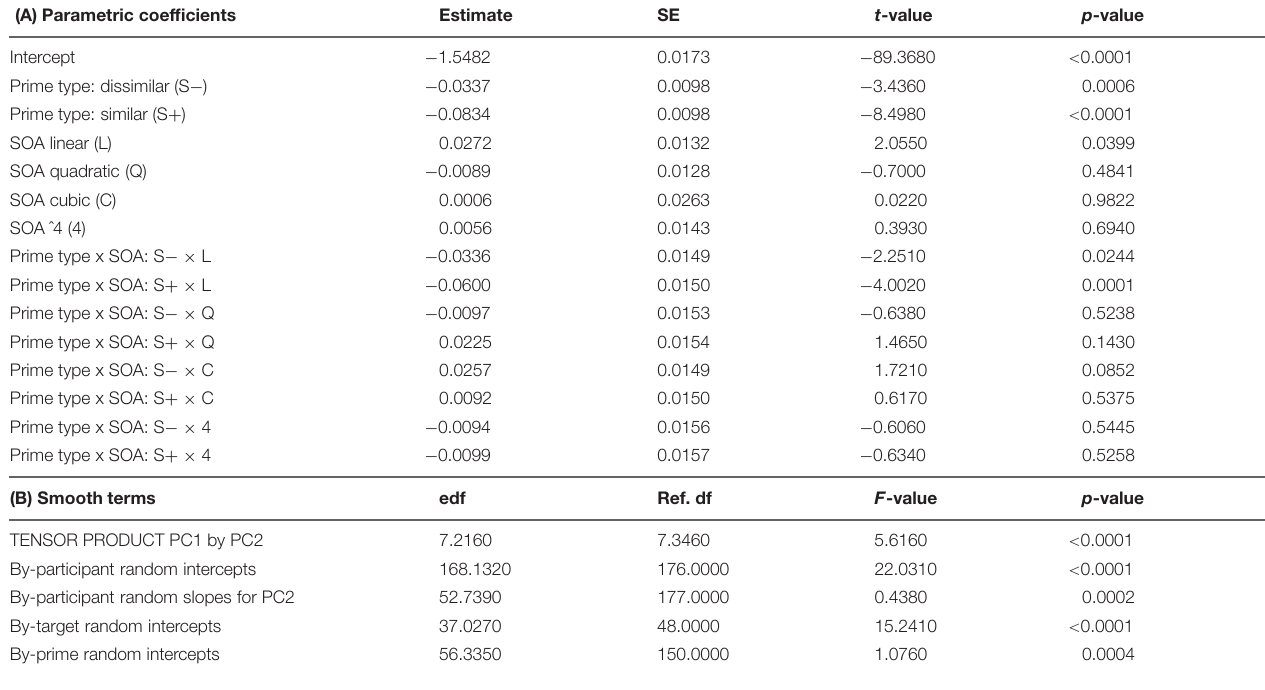
TABLE 3 | Generalized additive mixed model fitted to the lexical decision latencies for a range of SOAs (34, 50, 67, 84, 100), reporting parametric coefficients (A), and non-linear terms, tensor products, and random effects (B) with effective degrees of freedom (edf), reference degrees of freedom (Ref. df), F and p